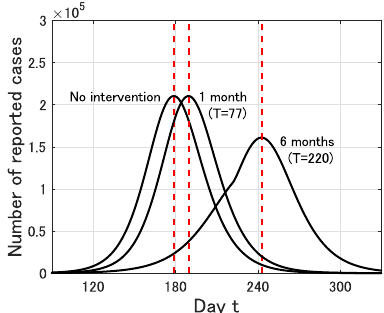
Figure 4. Time variation of the number Y ( t ) of infective individuals who are identified at time t (0 ≤ t ≤ 365) for p = 0.01 and no intervention, 1 month intervention ( T = 77) and 6 months intervention ( T = 220). The dot lines represent the epidemic peak.